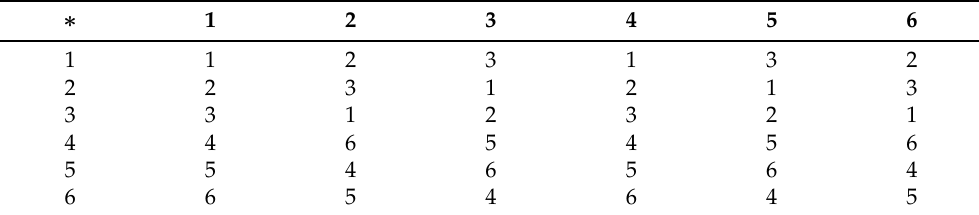
Table 11. A left transposition regular TA-groupoid with two right identity elements of Example